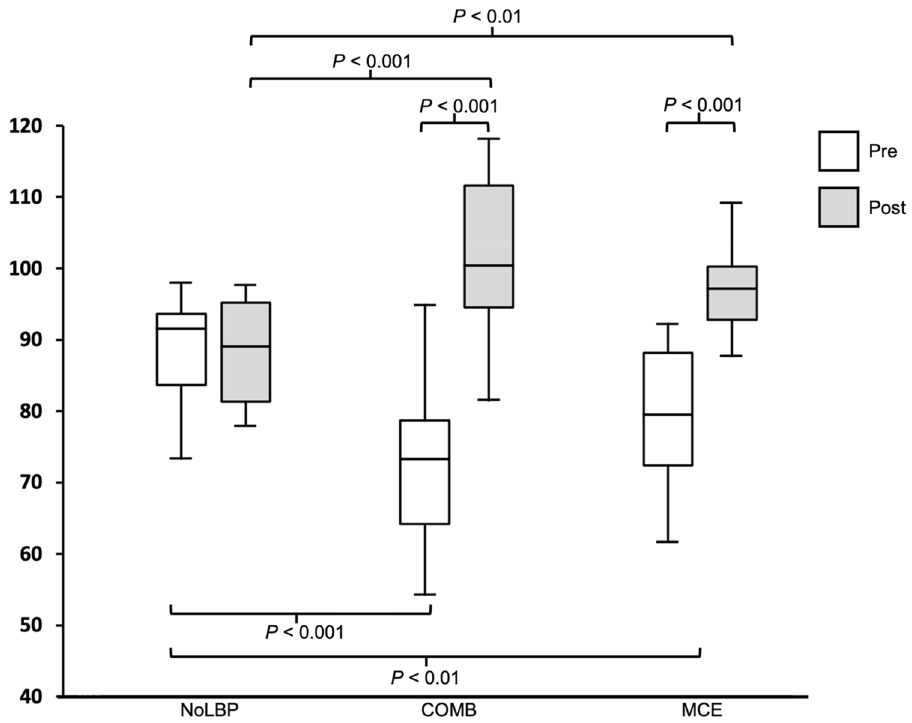
Figure 4. Lumbar multifidus muscle activation pairwise between-group comparisons among no low back pain (NoLBP), combined neuromuscular electrical stimulation with motor control exercise group (COMB), and motor control exercise group (MCE), as well as within-group comparison between baseline and post- intervention for each